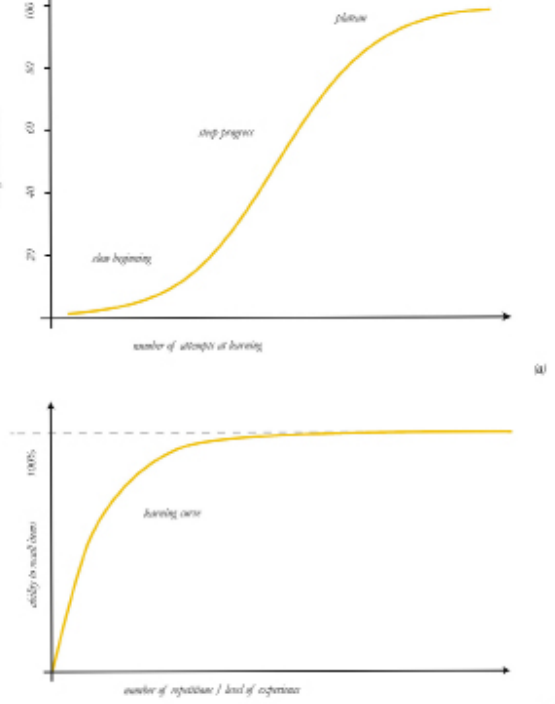
Fig. 2 Zambonini A.,